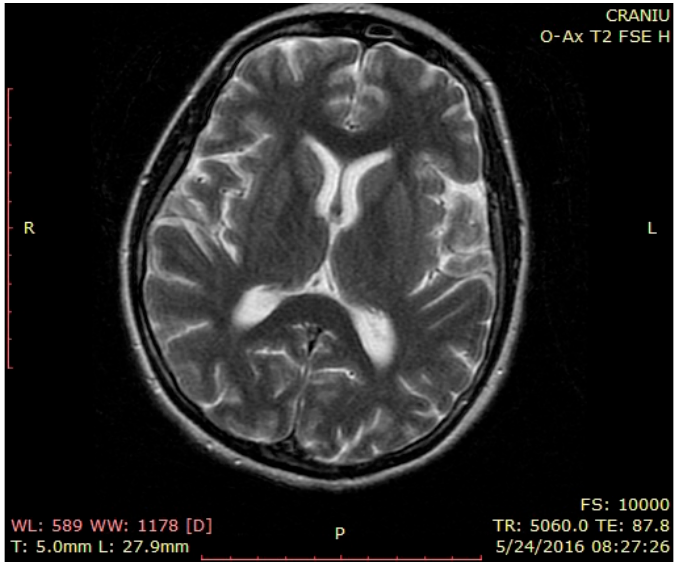
Figure 3. Brain MRI—normal findings (T2 weighted brain scan), axial insular image 2. Lumbar puncture: cerebrospinal fluid had normal transparency, 5 leucocytes/mL, 15 erythrocytes/mL, 67mg/mL glucose, 0.49 g/L proteins (normal findings). Laboratory